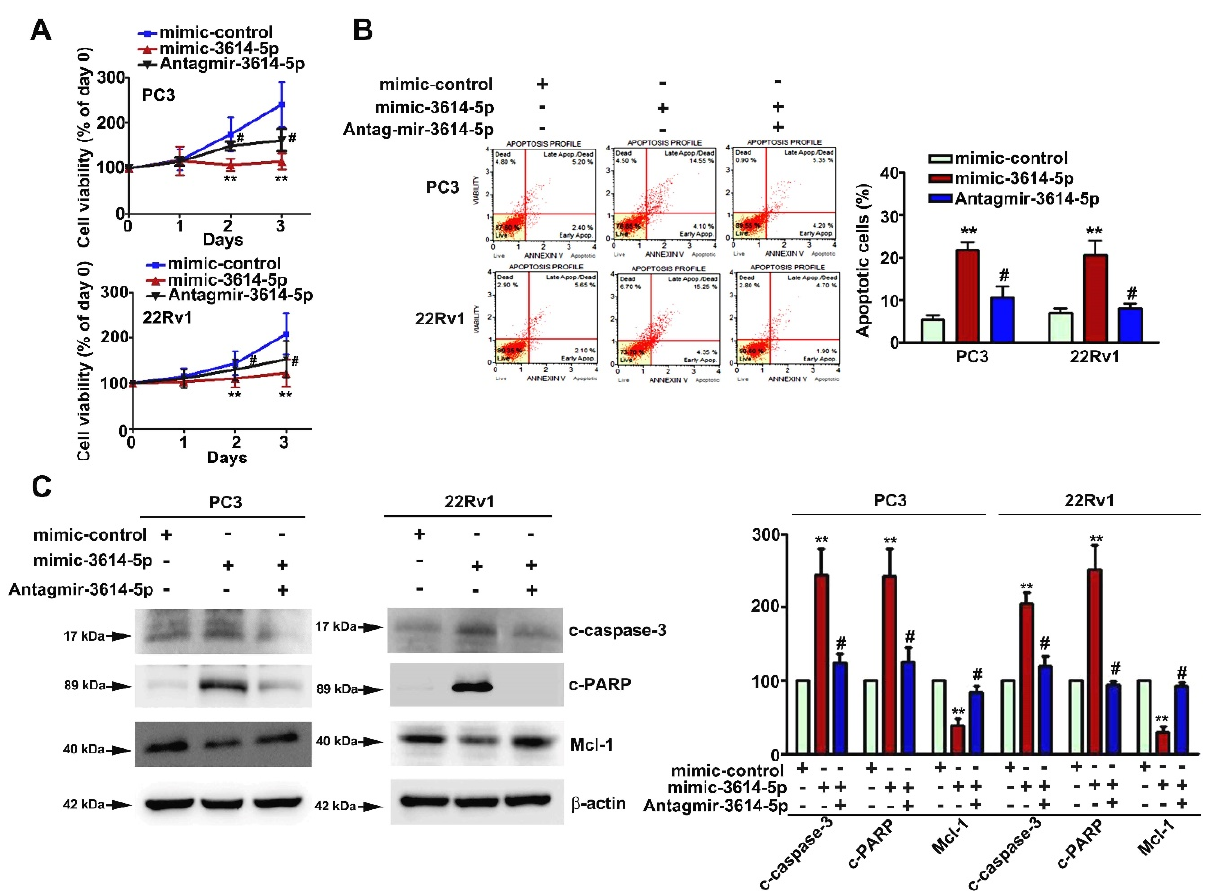
Figure 6. Effect of miRNA-3614-5p on cell viability, cell death and the expression of apoptotic-related proteins of human prostate cancer cells. Human PC3 and 22Rv1 cells were transfected with mimic-control or mimic-3614-5p for 48 h. ( A ) Cell viability was detected with MTT assay. ( B ) Apoptotic cells were measured with Annexin V/PI staining by flow cytometry. ( C ) The expression of cleaved caspase-3 (c-caspase-3), cleaved PARP ( c-PARP ) and Mcl-1 proteins were measured by immunoblotting analysis. Cells transfected with mimic-control as the control group. β -actin as a protein loading control. **, p < 0.01 versus control (mean ± SE, n = 3), #, p < 0.05 versus